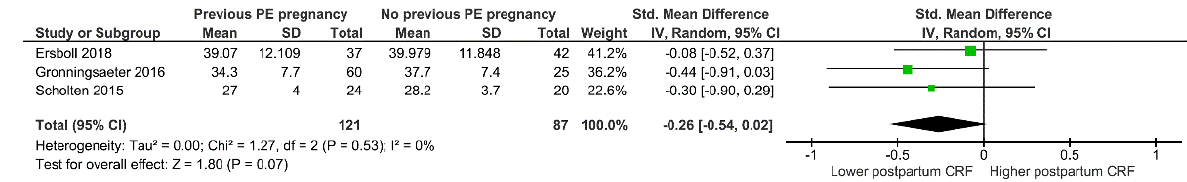
Figure 3. Mean differences in VO 2 peak (in mL/kg/min) in postpartum women with and without previous preeclampsia [17,22,32].